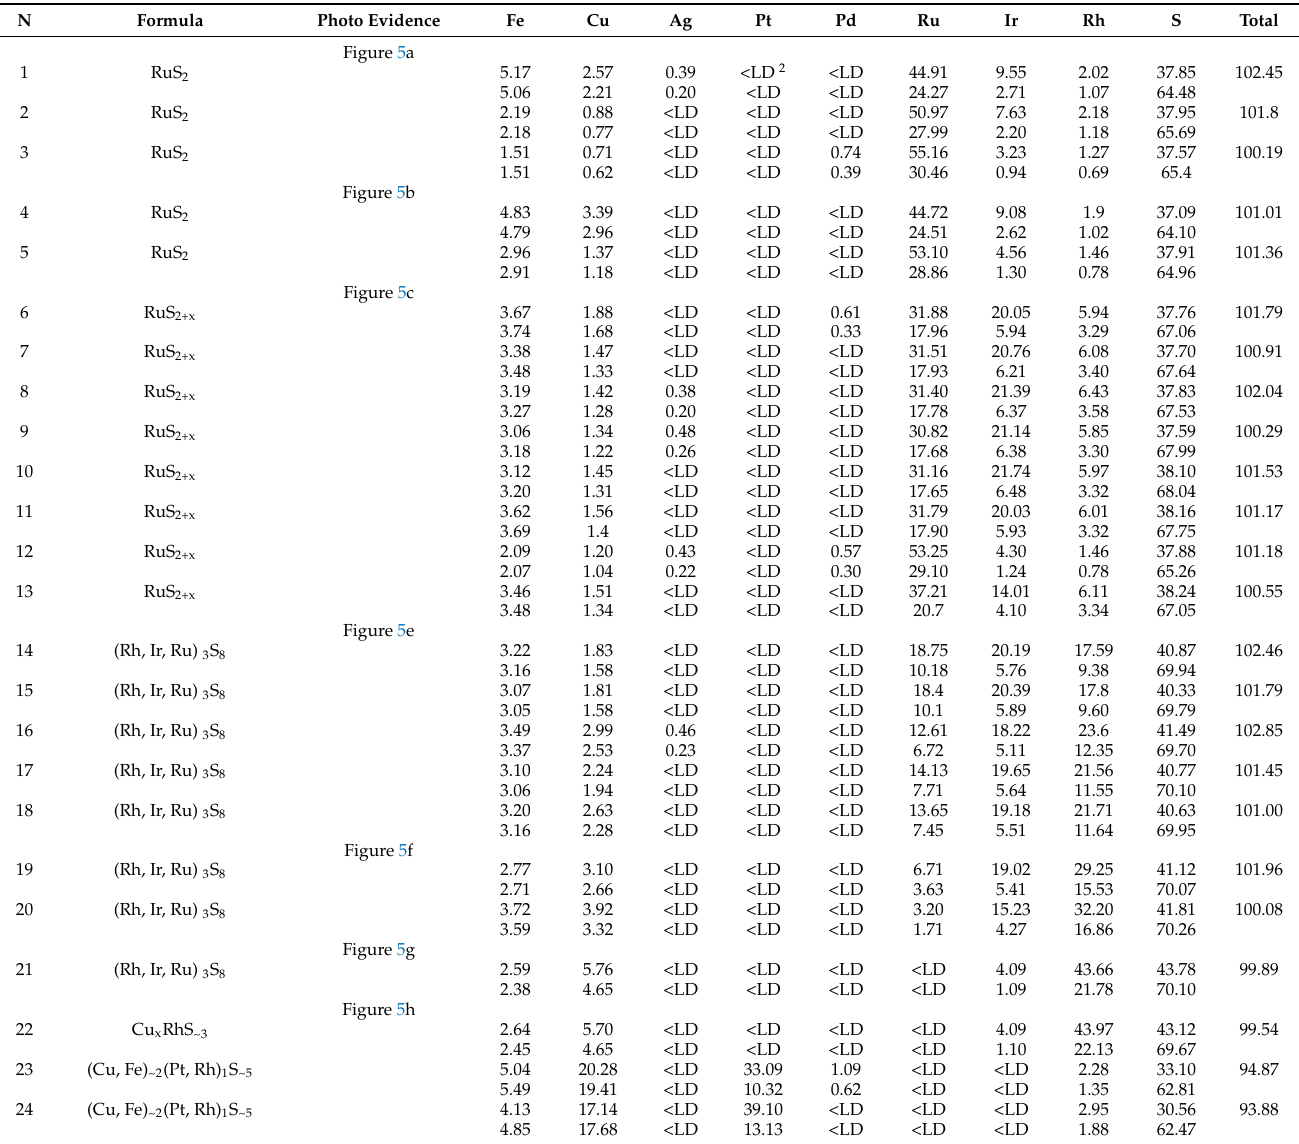
Table 3. Chemical characterization of microstructural noble metal phases by SEM/EDS 1